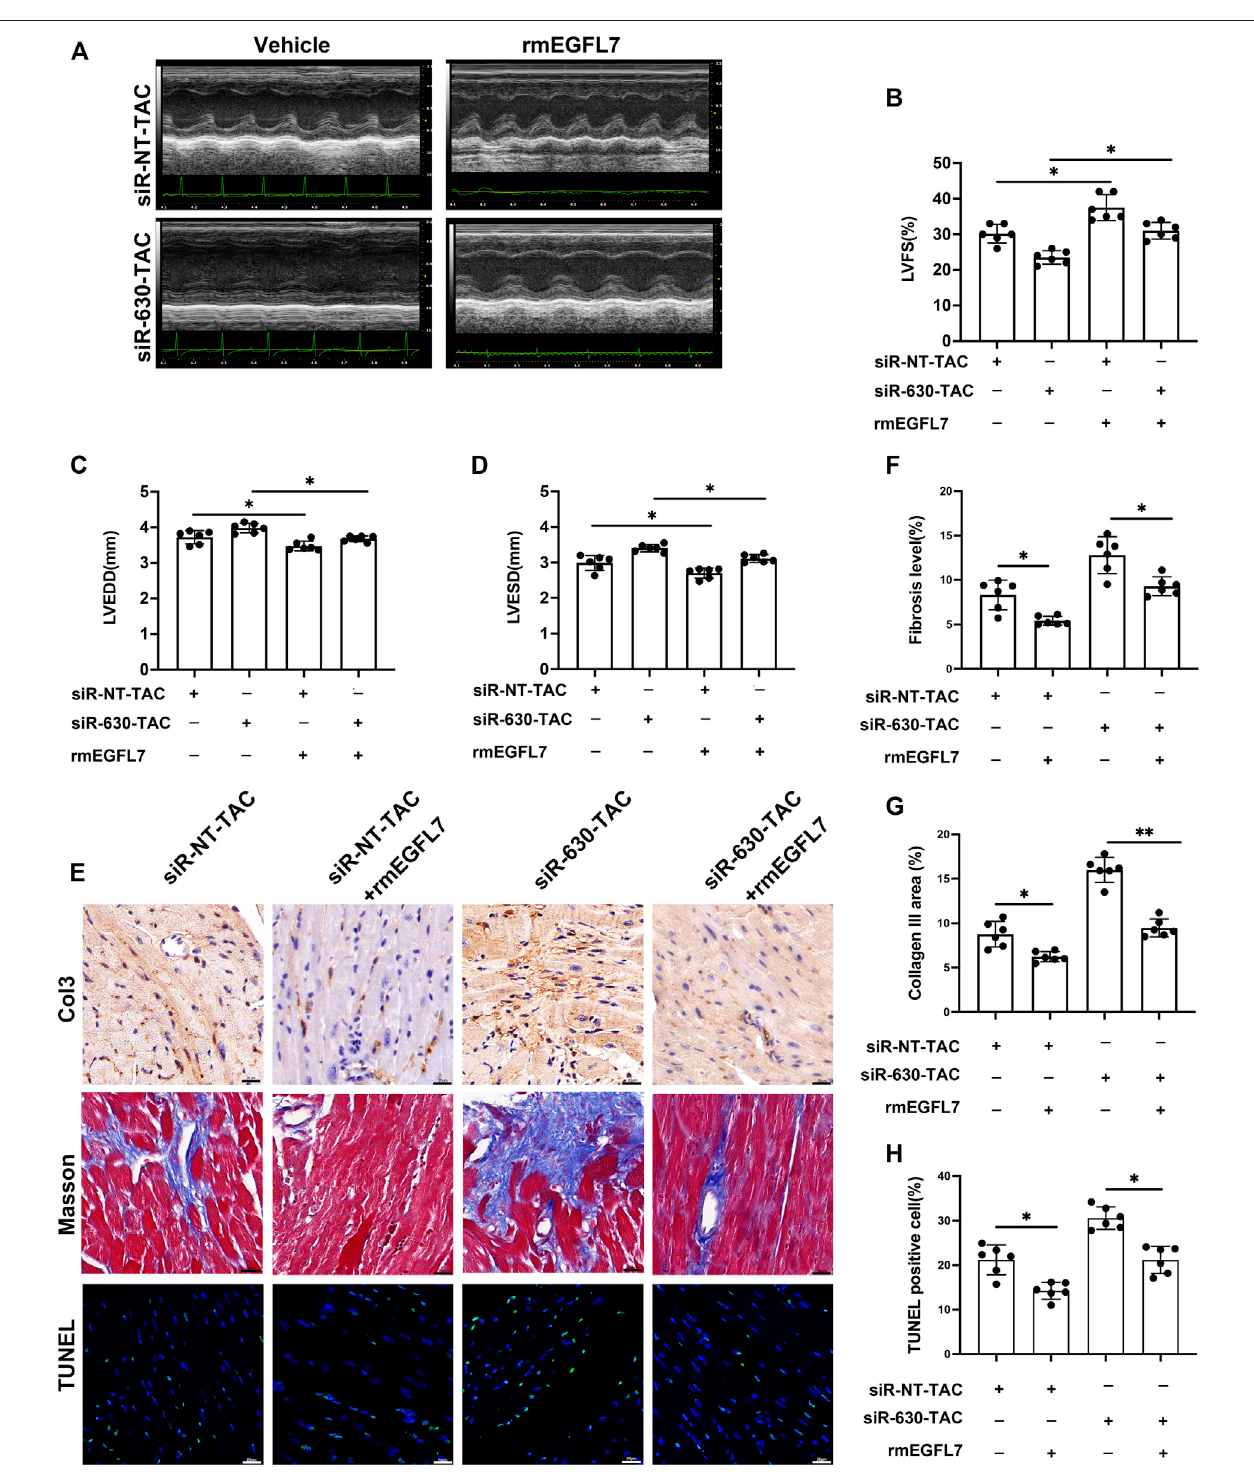
FIGURE 5 | rmEGFL7 treatment reduces cardiac remodeling and apoptosis in siRNA-TAC. C57BL/6J mice were subjected to TAC operation, followed by siRNA- NTorsiRNA-630 injectiontwiceaweekfor4 weeks.Recombinantmice (rm)EGFL7 orvehicles wereinjectedintraperitoneallyeveryday for4 weeks.Heart functionand morphological measures were observed at 4 weeks. ( n = 6 in each group). (A – D) Representative echocardiograms and quantitative analysis of left ventricle fractional shortening (LVFS), left ventricle end-diastolic diameter (LVEDD), left ventricle end-systolic diameter (LVESD) (* p < 0.05, ** p < 0.01 by one-way ANOVA followed by Tukey ’ stest). (E,G) RepresentativeimmunohistochemicalstainingofCollagenIIIandquantitativeanalysis(* p < 0.05,** p < 0.01byone-wayANOVAfollowedbyTukey ’ s test). scale bar = 20 μ m. (E, F) representative Masson image indicated fi brosis and quantitative analysis (* p < 0.05, ** p < 0.01 by one-way ANOVA followed by Tukey ’ s test). Scale bar = 20 μ m. (E, H) representative TUNEL images indicated apoptosis and quantitative analysis (* p < 0.05, ** p < 0.01 by one-way ANOVA followed by Tukey ’ s test). Scale bar = 20 μ m. All data represent the mean ± SD from at least 4 independent